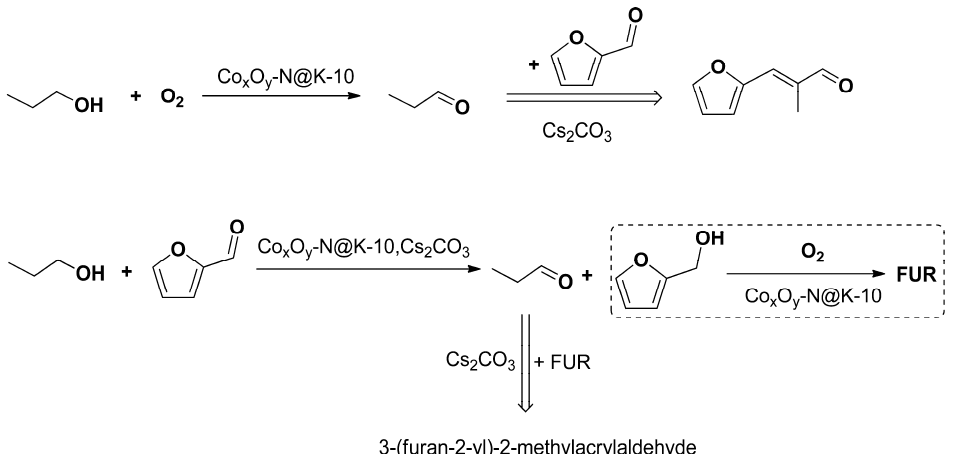
Figure 6. Oxidative condensation of furfural with various alcohols. Reaction conditions: 0.2 g of furfural, 0.05 g Co x O y -N/K-10 catalyst (2 wt% loading) and 0.05 g Cs 2 CO 3 , 15 mL n-propanol, 0.3 MPa O 2 , 140 °C, 4 h. b The conversion of furfural. c The selectivity of oxidative condensation products. Reproduced with permission from [26]. Copyright: American Chemical Society 2016.